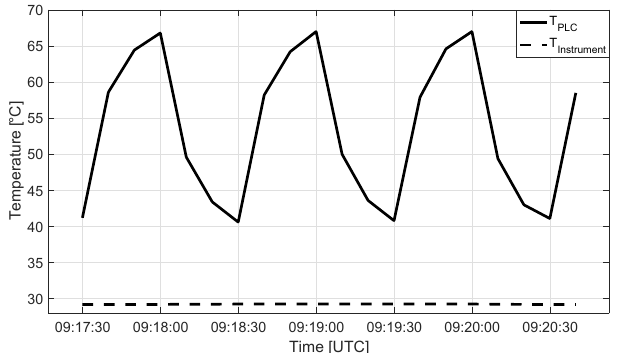
Figure 3. Gas temperature in the photolytic converter and instru- ment temperature measured in the laboratory when switching the UV-LEDs on and off every